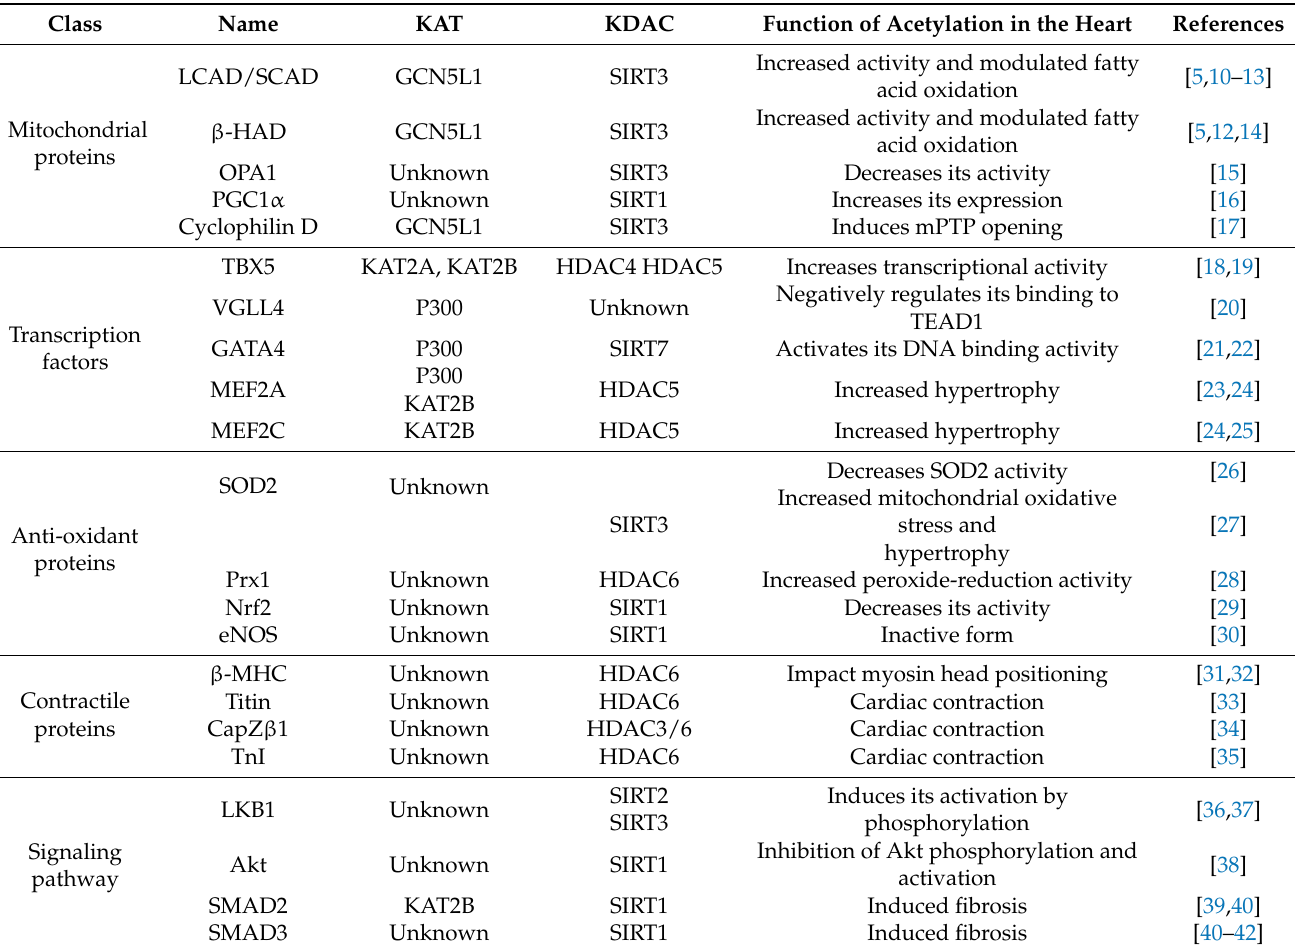
Table 1. Most common proteins modified by cardiac acetylation in cardiovascular and metabolic